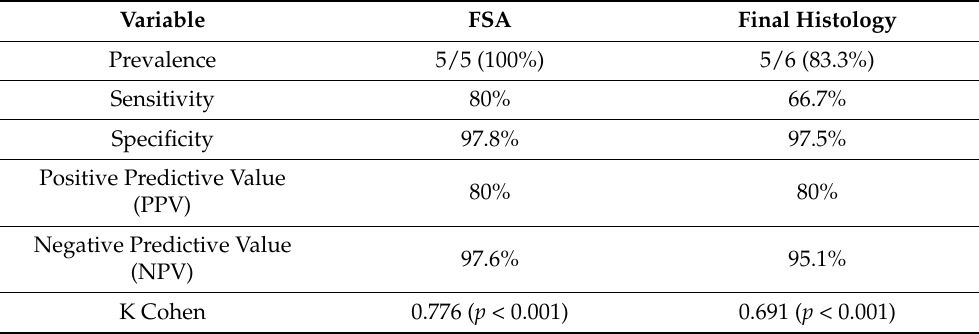
Table 2. Concordance evaluation of FCM at a urethral level between FSA and final histology.